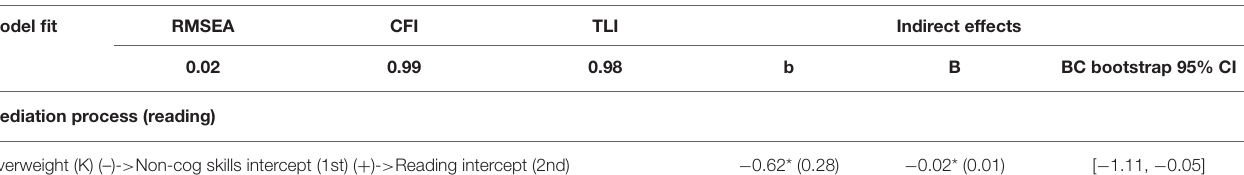
TABLE 2 | PP-LGM mediation model for boys ( n =